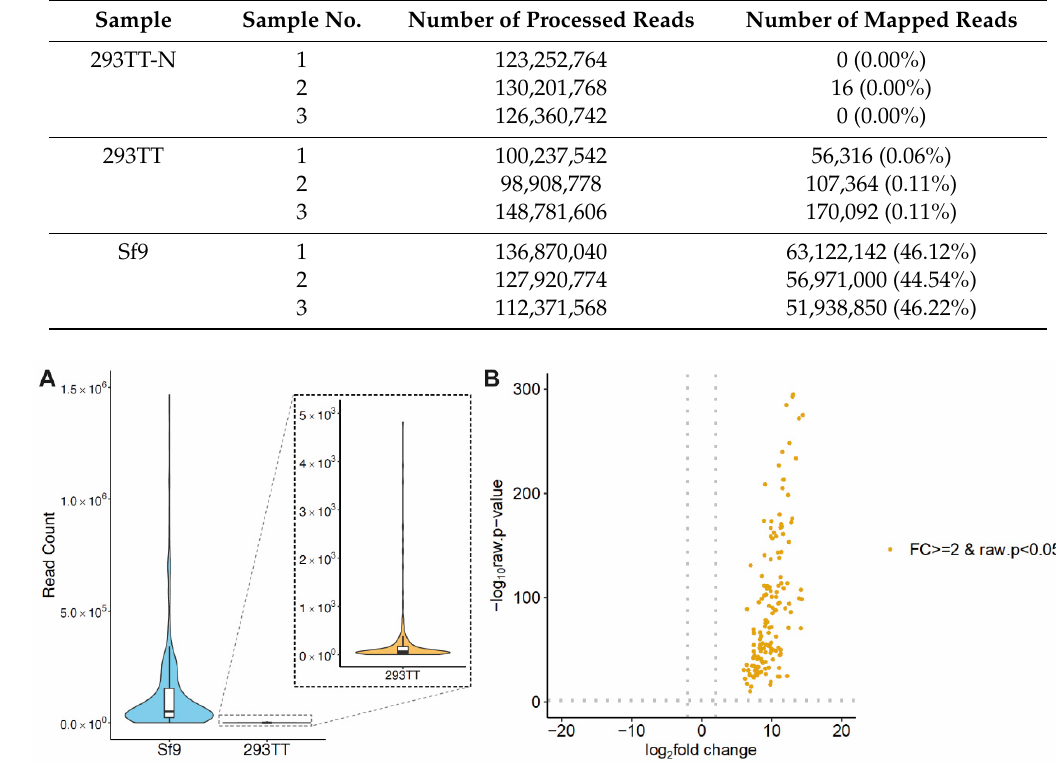
Table 1. Mapping ratio of baculovirus genes for AcHERV env -CMV-GFP-infected cells.